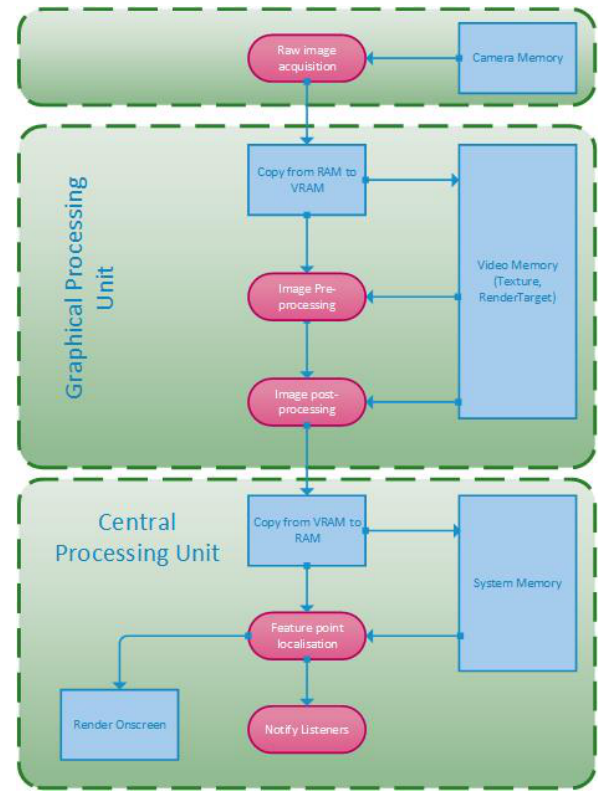
Figure 1: Overview of system architecture the low instruction count imposed by Shader Model